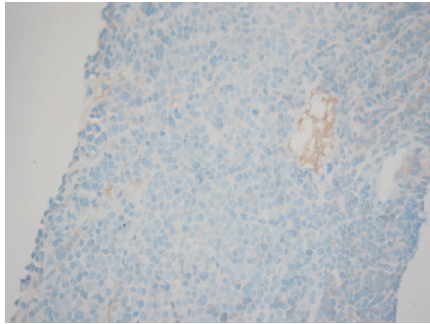
Figure 6: Liver biopsy stained for kappa light chain immunoglob- ulin confirming neoplastic extramedullary plasma cell infiltration from multiple myeloma.